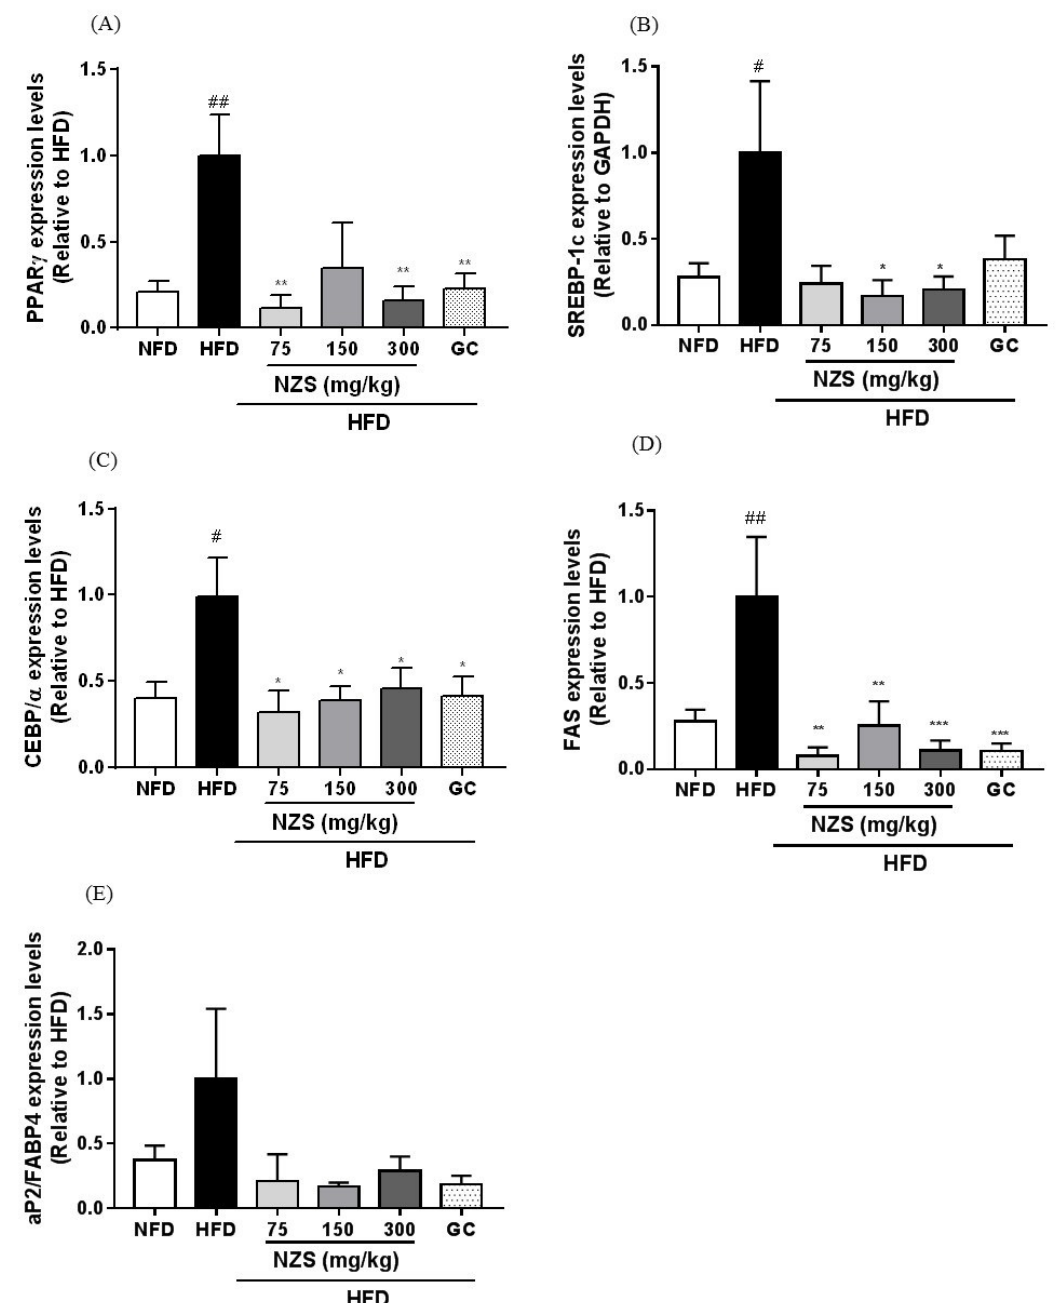
Figure 3. Effects of NZS on the expression levels of adipogenesis-related genes in WAT. mRNA expression levels of ( A ) PPARγ, ( B ) SREBP-1c, ( C ) CEBP/α, ( D ) FAS, and ( E ) aP2/FABP4. NFD: normal-fat diet; HFD: high-fat diet; NZS: Tetragonia tetragonoides (Pall.) Kuntze extract (New Zealand spinach); GC: Garcinia cambogia extract. Values are expressed as mean ± SEM ( n = 5). # p < 0.05 and ## p < 0.01 versus the NFD group; * p < 0.05, ** p < 0.01, and *** p < 0.005 versus the HFD group.